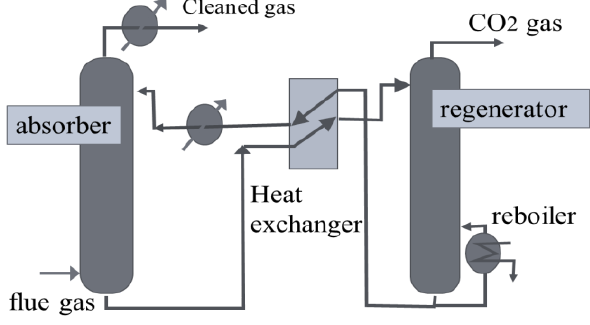
Figure 5. CO 2 absorption–desorption process.